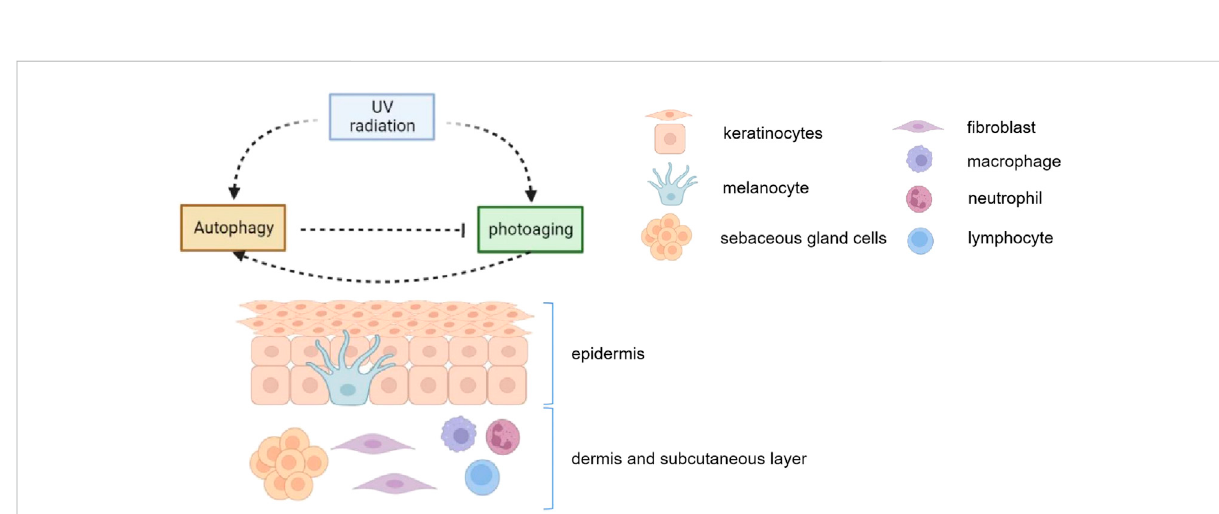
FIGURE 2 UV radiation activates autophagy in epidermal keratinocytes, melanocytes, dermal fi broblasts and sebaceous gland cells. Meanwhile, the inductionofautophagyhelpsmaintainthehomeostasisinthosecells.Autophagy1)inducesmelanosomedegradation invitro ,alleviatesmelanocyte in fl ammation and may protect against UV-induced pigmentation; 2) inhibits in fl ammatory response, prevents peroxidation in keratinocyets; 3) maintans the normal activity in fi broblasts after UV radiation; 4) regulates in lipids secretion and proportion in sebaceous glands. Therefore, autophagy plays an important role in maintaining the balance of skin cell senescense and cell